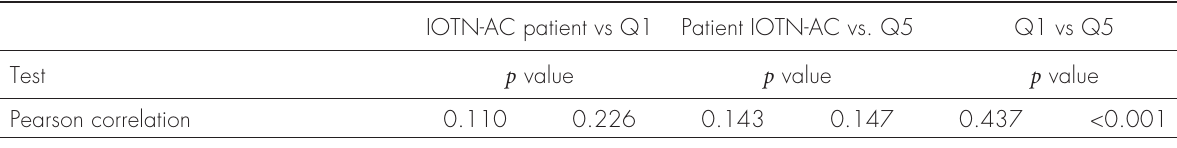
Table V. Correlation between patient IOTN AC and Questionnaire items Q1 and